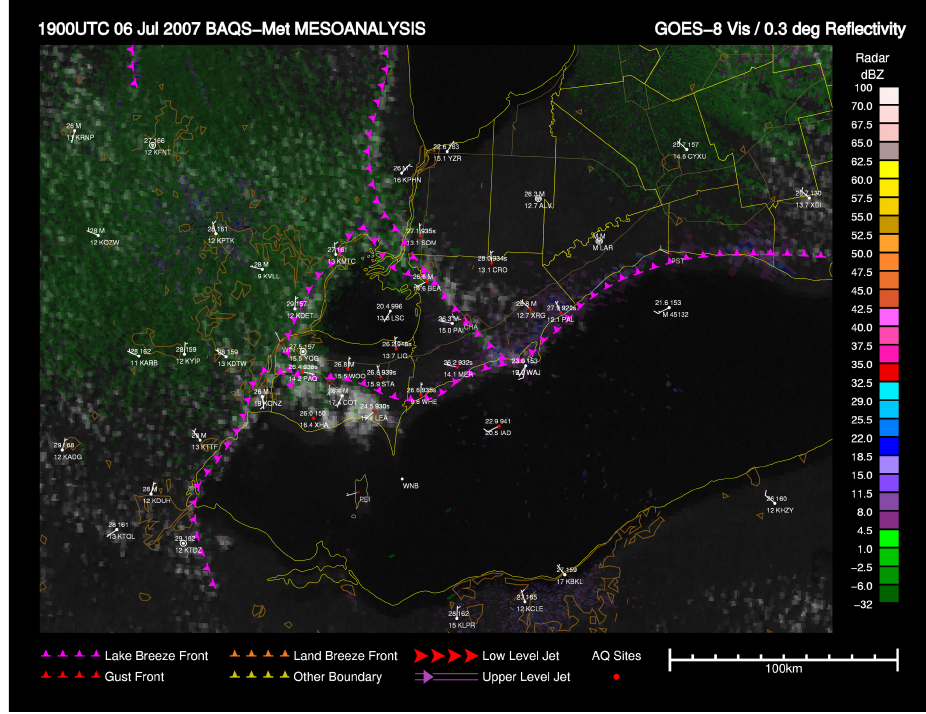
Fig. 3. Mesoscale analysis showing low-level radar echoes (mainly green), visible satellite imagery, surface observations, and the positions of lake-breeze fronts (broken magenta lines) for 15:00 LT on 6 July 2007. Long wind barbs are 5ms − 1 , short barbs are 2.5ms − 1 .